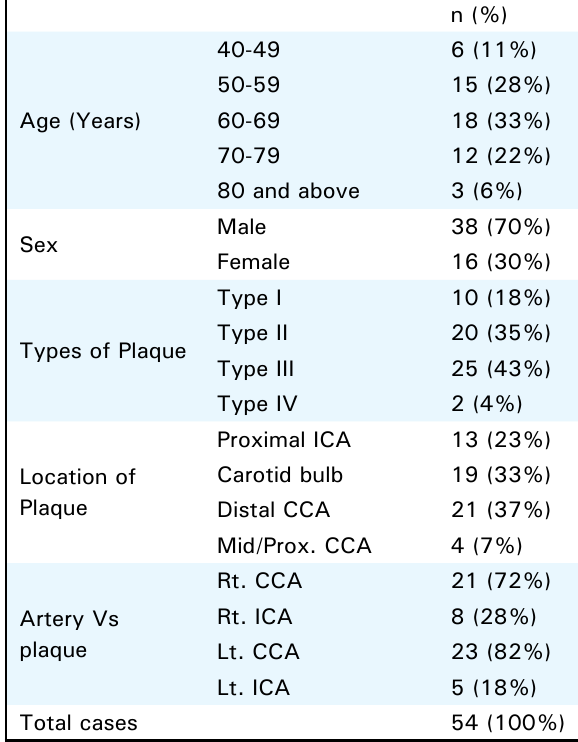
Table 1. The general characteristics of the